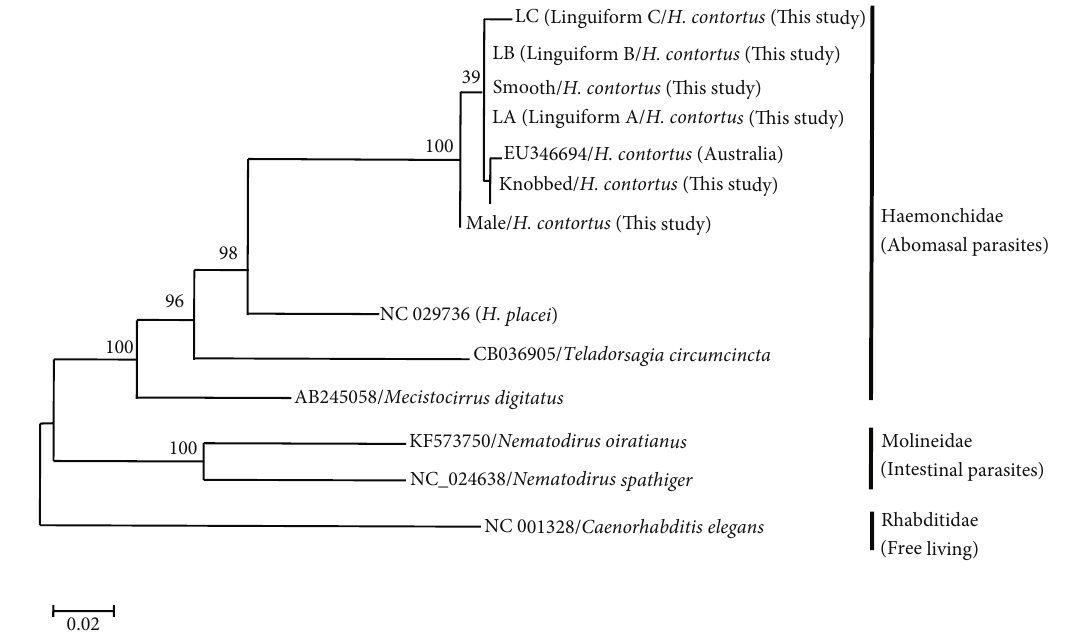
Figure 4: Inferred phylogenetic relationship of Haeamonchus contortus (present study) showing the relationship with H. placei with other abomasal nematodes of Haemonchidae in cluster I and intestinal parasites of Molineidae family in cluster II, and the Rhabditidae a free living as outgroup based on Cox 1 by BI and ML analyses. Table 3: Genetic divergence among the Haemonchus contortus male and female morph types isolated from Babati district, Tanzania. Male LC